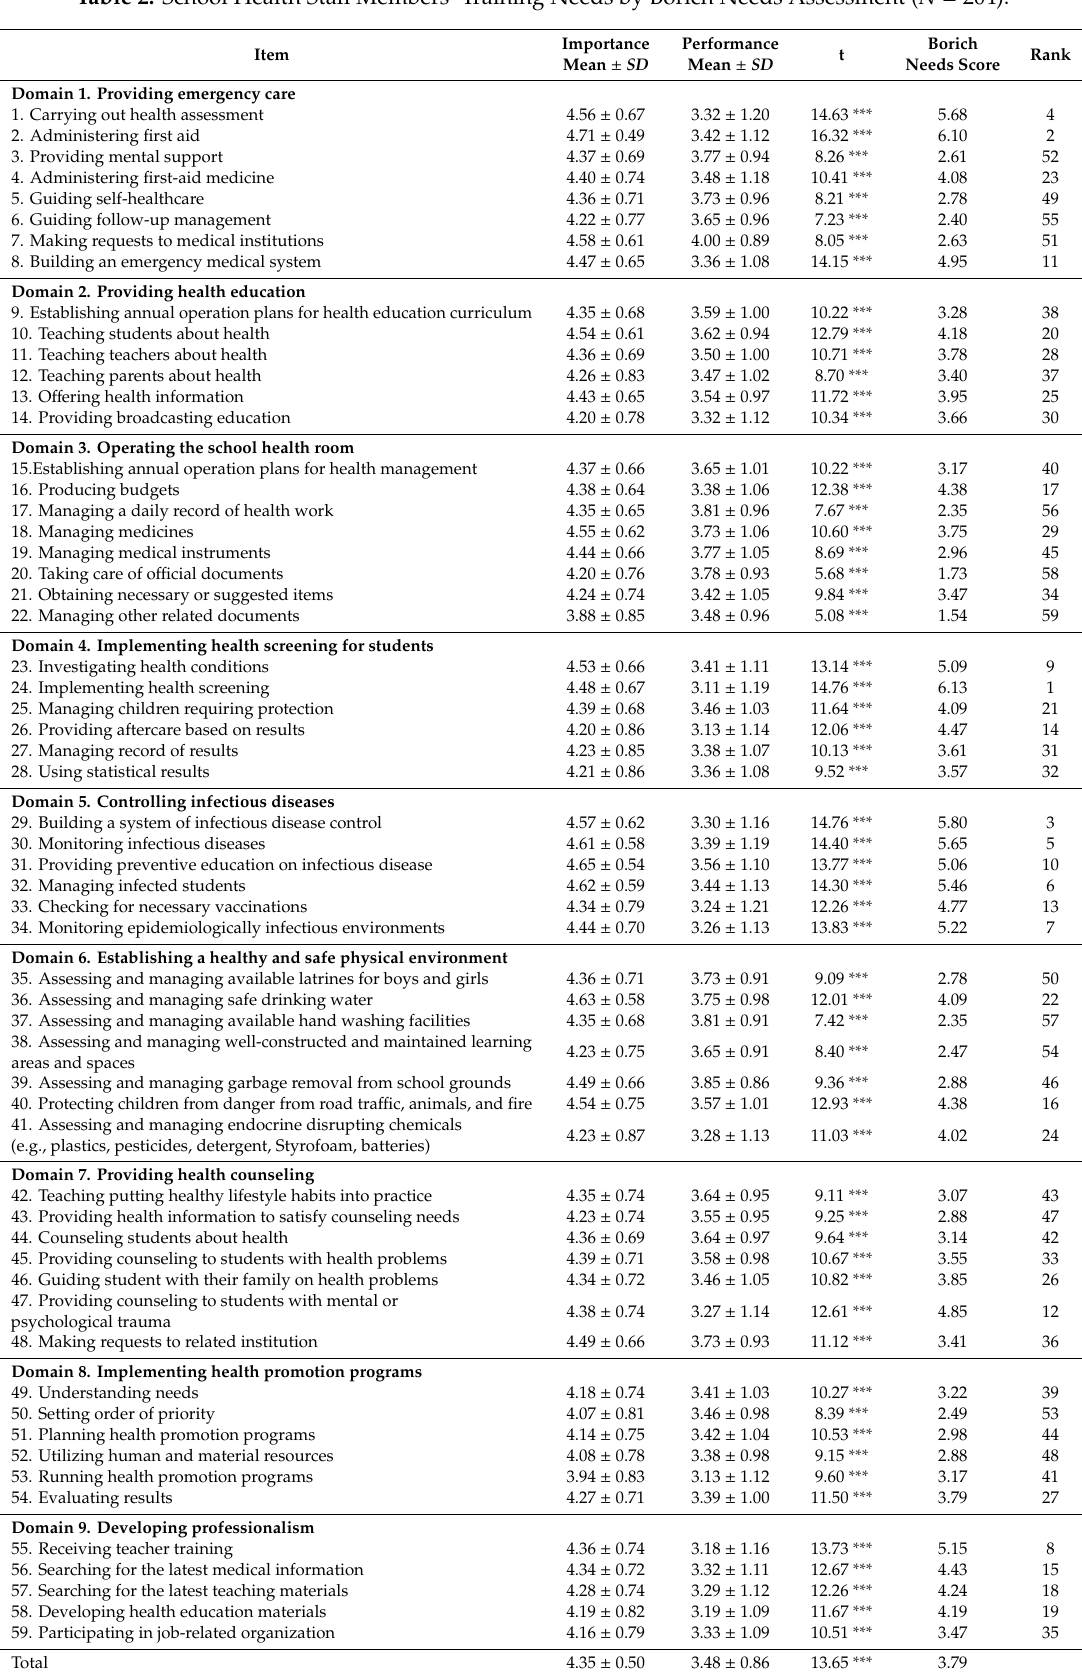
Table 2. School Health Sta ff Members’ Training Needs by Borich Needs Assessment ( N = 204).